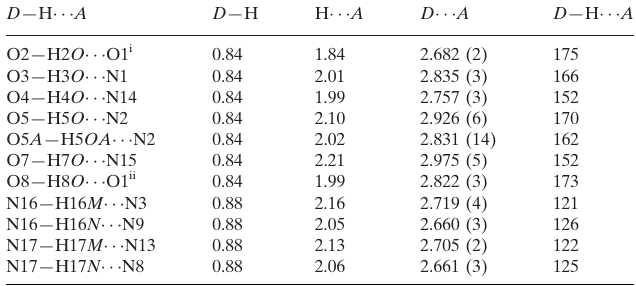
Hydrogen-bond geometry (A˚ , (cid:3)